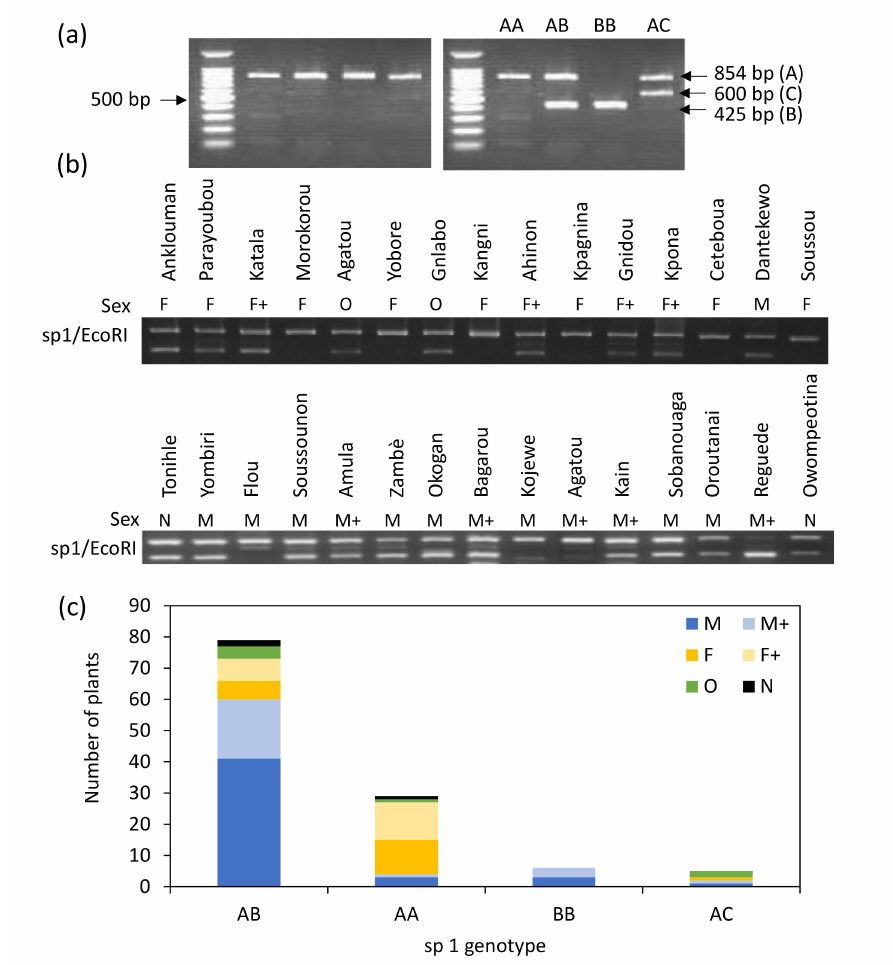
Figure 3. Analysis of the genetic marker sp1 in cultivars of the D. rotundata species of Benin. ( a ) The four profiles obtained before (left) and after (right) restriction with EcoRI. ( b ) PCR amplification and restriction for sp1 in a few cultivars. ( c ) Distribution of individuals according to their sex identity and the genotypes (AB, AA, BB, AC) for the sp1 marker. M, stable male; M + , unstable male; F, stable female; F + , unstable female; O, monoecious; and N,